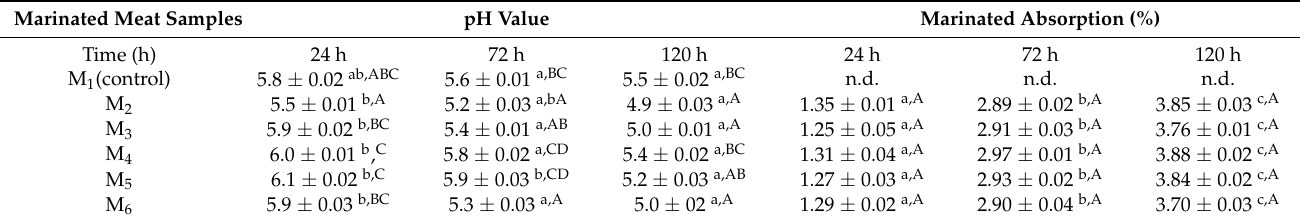
Table 2. pH and marinade absorption values of the marinated beef